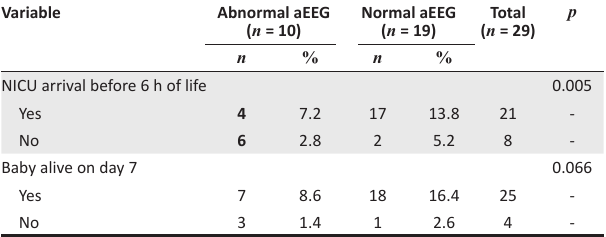
TABLE 5a (Continues ...): Associations between variables and outcomes (abnormal amplitude electroencephalograms and mortality) represented by cross-tabulations and chi-square tests.